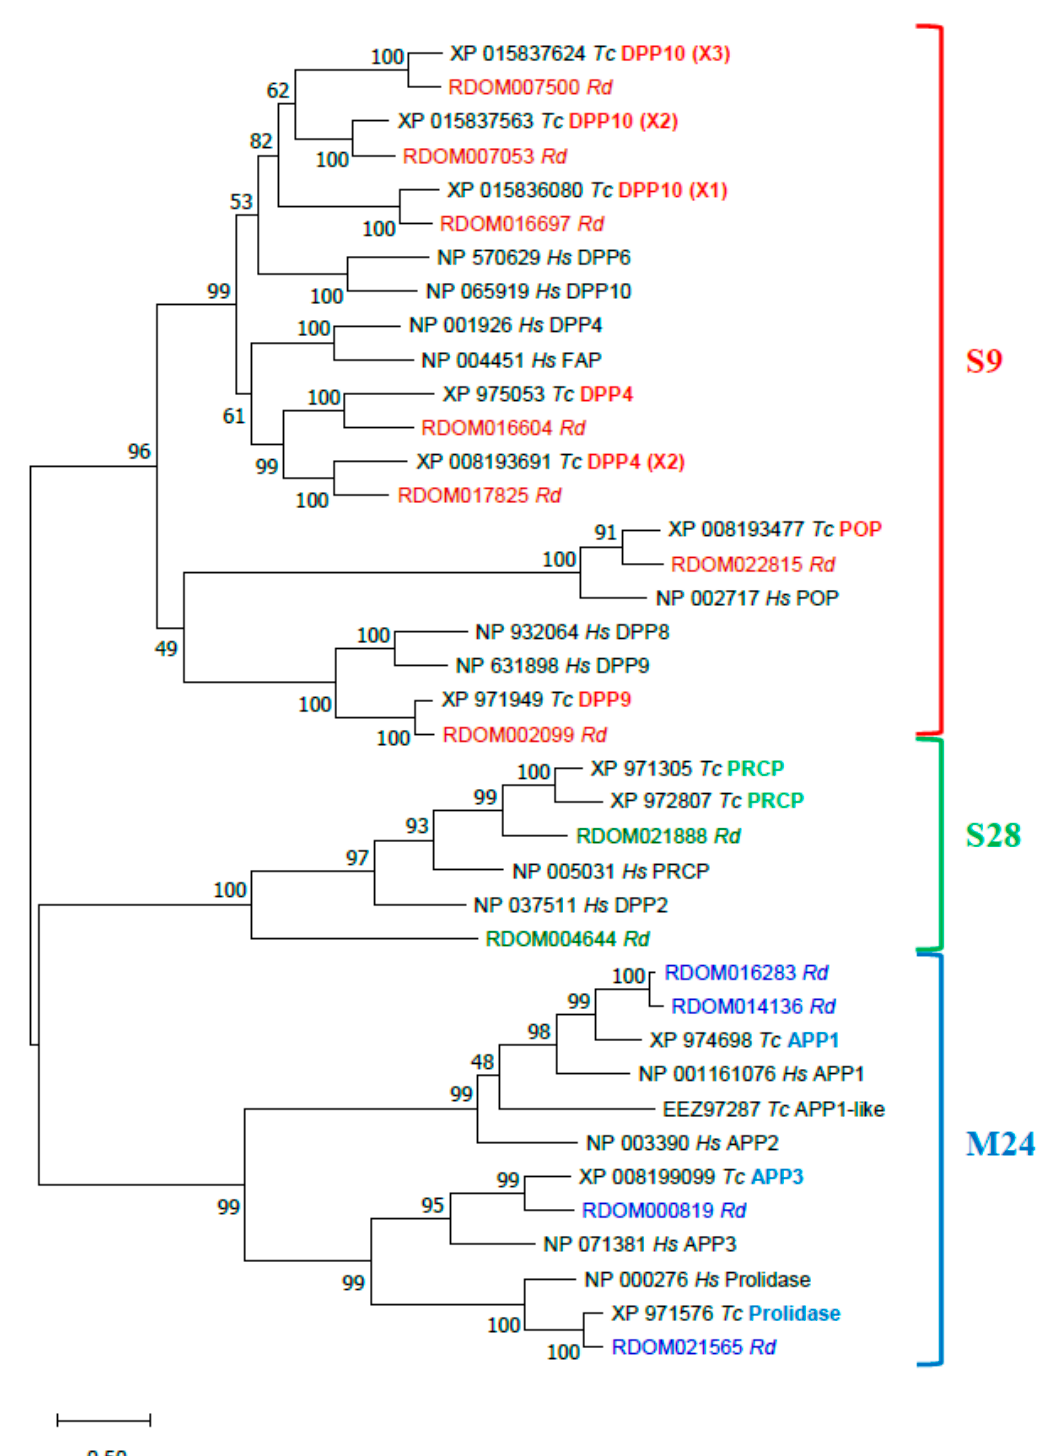
Figure 7. Phylogenetic analysis of R. dominica, T. castaneum, and H. sapiens PSPs. Maximum Likelihood trees with 500 iterations of bootstrapping were used; bootstrapping values are represented as a percentage (0–100) by each branch. Evolutionary distances are represented by branch’s length. Serine PSPs of S9 family are colored with red, S28 with green, and metallopeptidases of M24 with blue. Types of peptidases (on the example of T. castaneum ) are indicated in bold with corresponding color; X1, X2, X3—mean isoforms of one type. R. dominica sequences are colored according to the